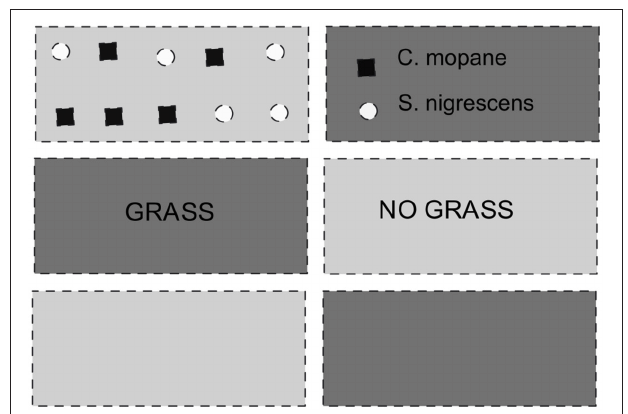
FIGURE 2 | Experimental layout. Each 30 × 30m plot consisted of 6 blocks with three replicated sub-plots of grassy treatments and three replicates subplots of a cleared treatment, where all grass was removed. Five plants of each species were planted in each replicate, at one meter